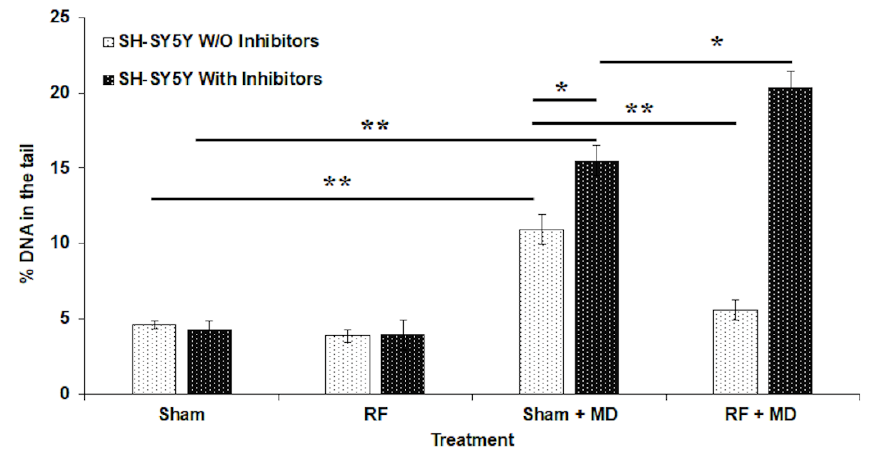
Figure 1. % DNA in the tail in SH-SY5Y cells exposed to RF, 0.3 W/kg SAR, for 20 h, in presence (With) and absence (W/O) of autophagy inhibitors. For each condition, the following samples were analyzed: sham-exposed (Sham), RF-exposed (RF), sham-exposed and treated with MD (Sham + MD), and RF-exposed and treated with MD (RF + MD). Each data point represents the mean ± SE of the 4 independent experiments. * p < 0.05; ** p < 0.01 (two-tailed unpaired Student’s t -test).